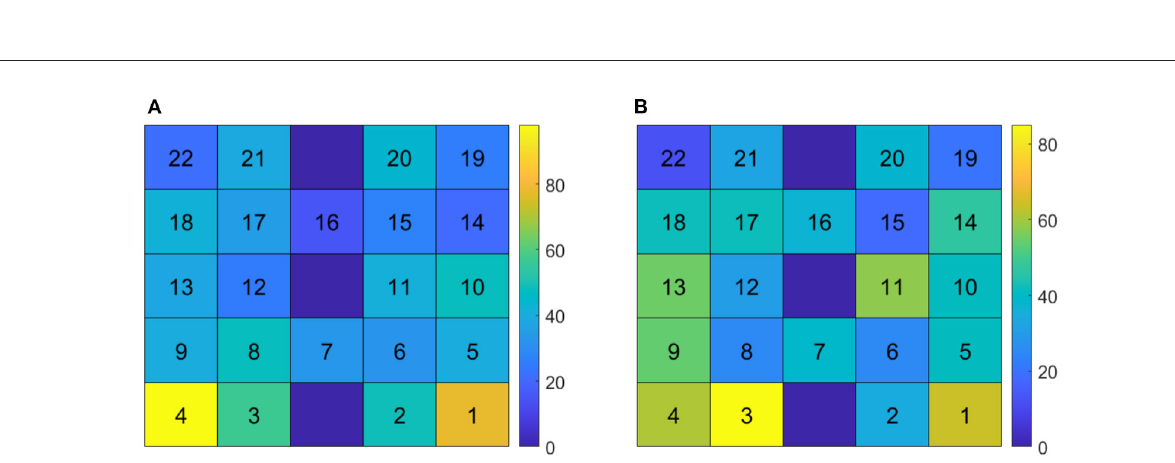
FIGURE8 Channel selection frequency across participants and sessions. (A) Channel selection frequency for 1 [Hb] features. (B) Channel selection frequency for 1 [HbO] features. The bottom row corresponds to channels directly over the nose; channels 2 and 3 correspond approximately with Fp1 and Fp2 of the 10/20 EEG standard